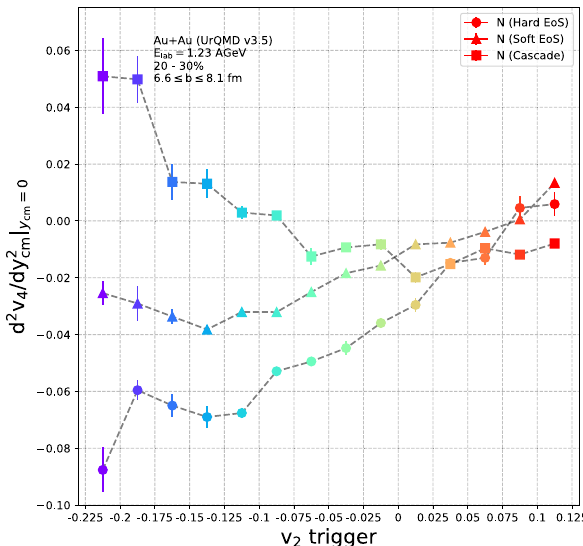
Fig. 7 The curvature of the quadrangular flow component v 4 of nucle- ons at y cm = 0 as a function of the final state elliptic flow v 2 integrated over − 0 . 5 ≤ y cm ≤ 0 . 5 for a hard EoS (circles), a soft EoS (triangles) and in cascade mode (squares) from 20–30% peripheral Au+Au collisions at 1.23 AGeV from UrQMD